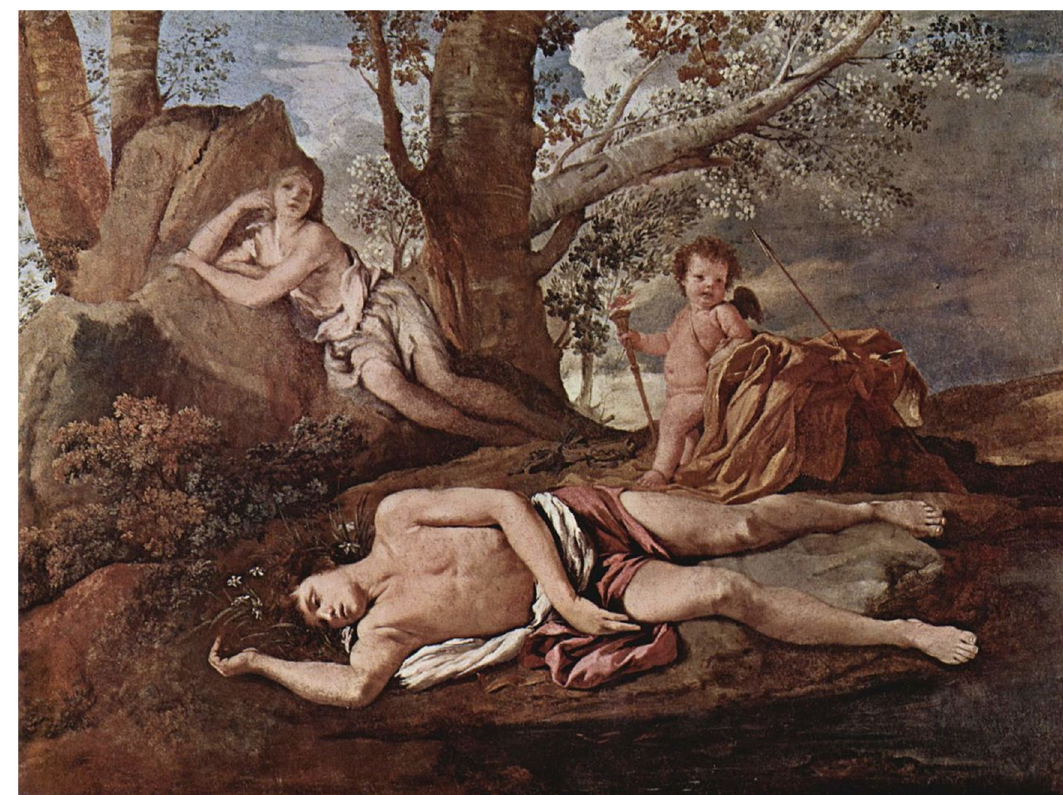
Figure 34: Poussin, Echo and Narcissus , ca. 1629 – 1630,